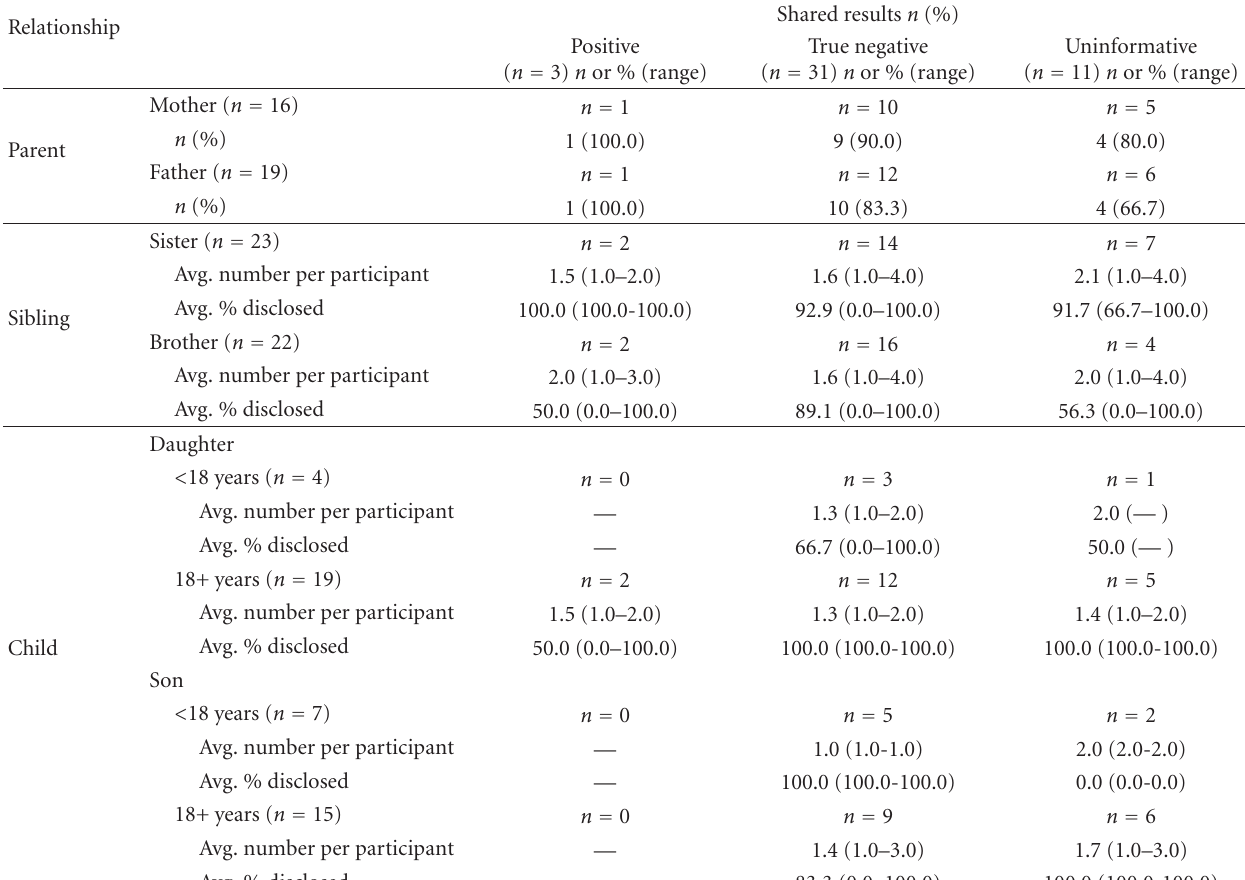
Table 2: Frequency of sharing test results with first-degree relatives by mutation